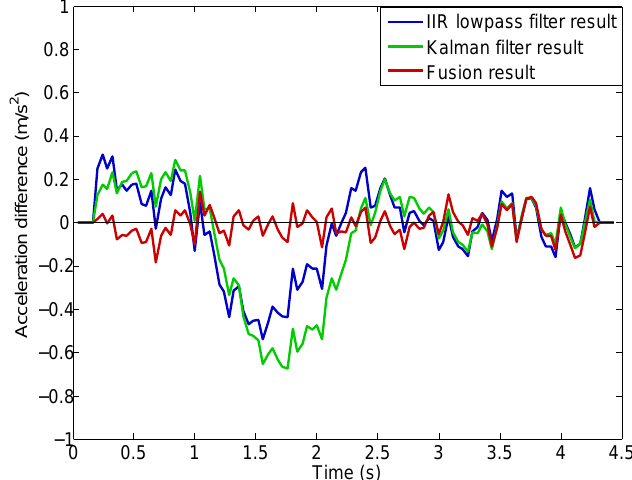
Figure 18. Low frequency component of acceleration